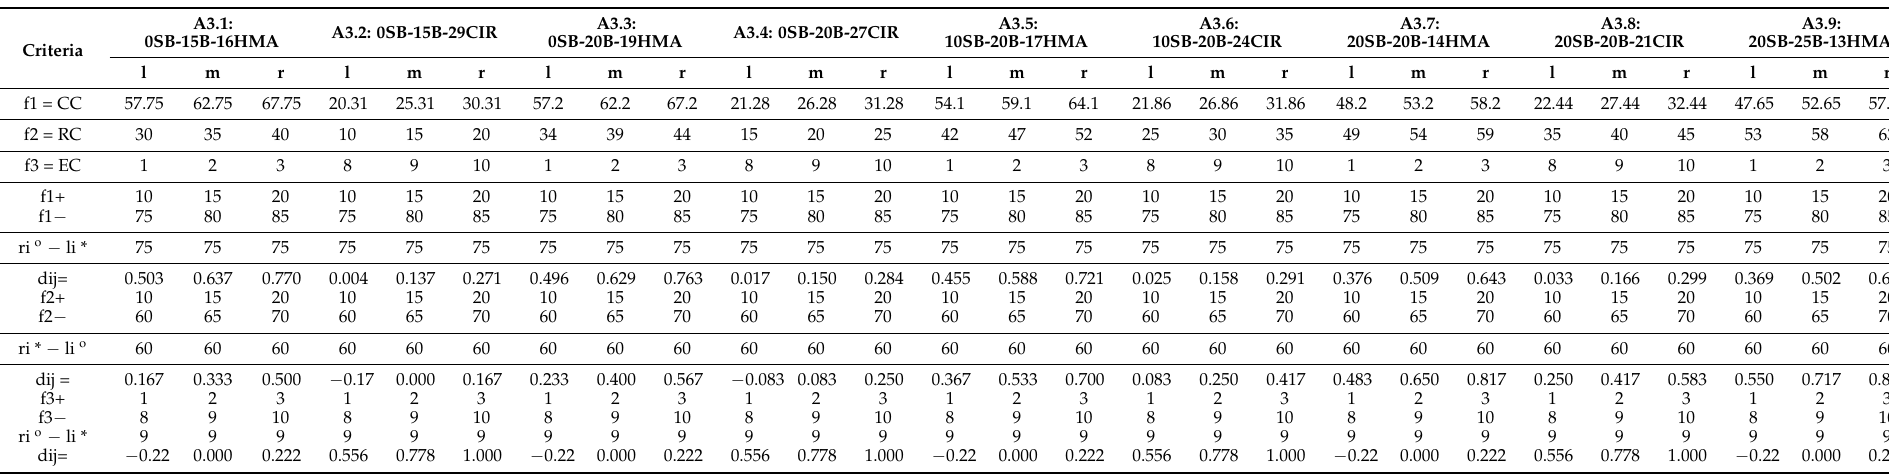
Table 5. Example of scoring matrix for nine scenarios (No. 10 not included due to space limitations) for medium traffic class.